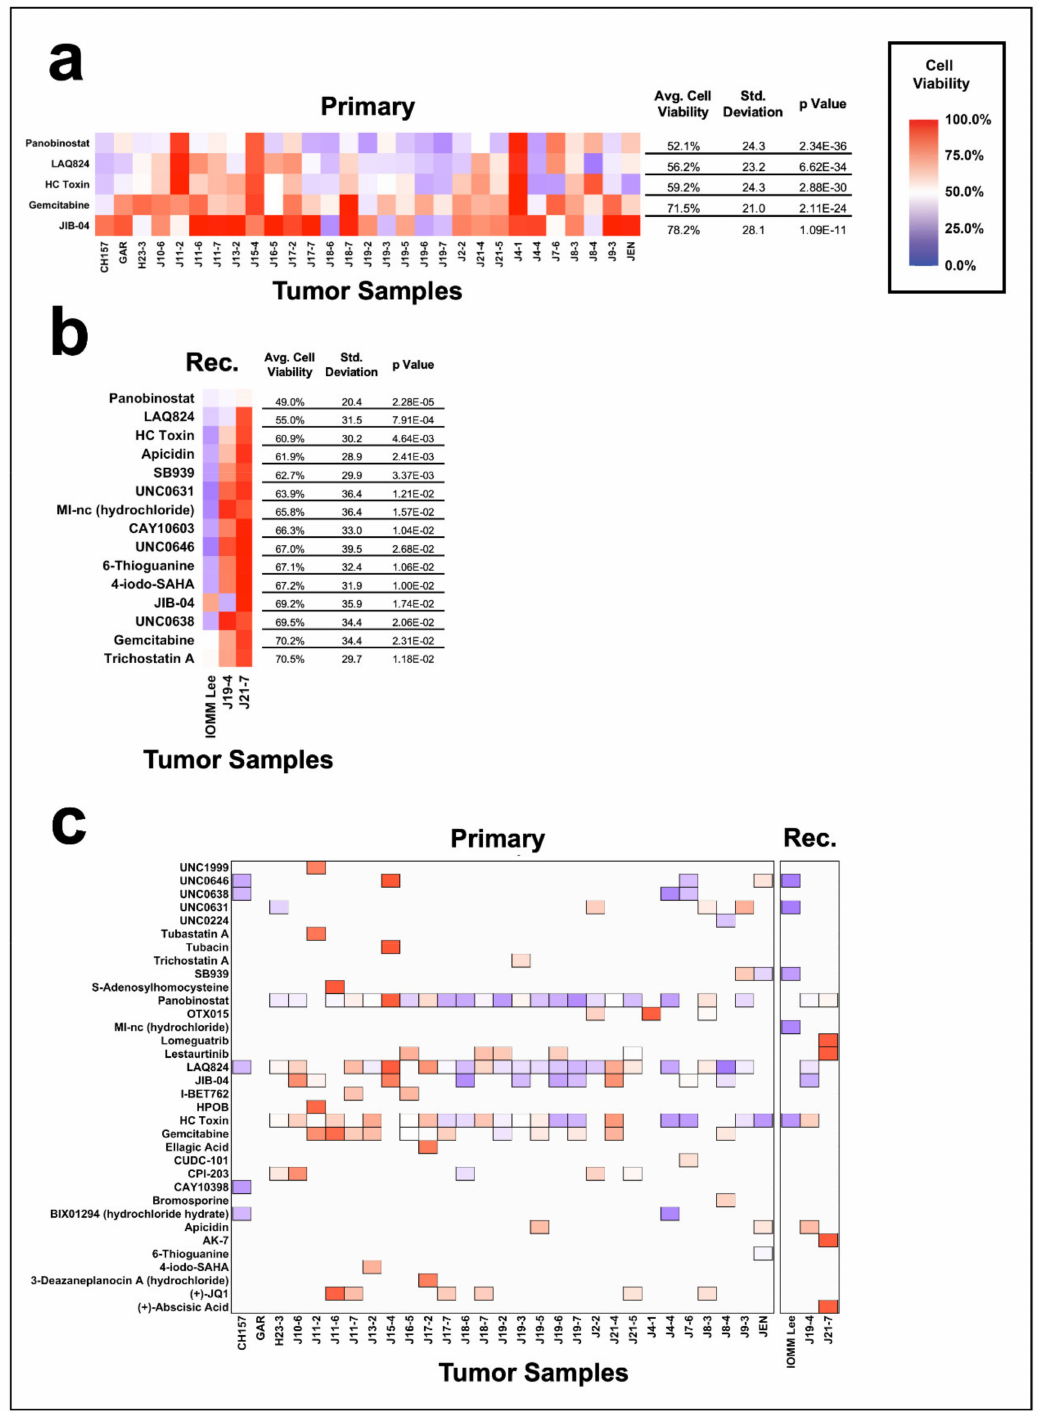
Figure 4. Comparison of the meningioma cohort separated by primary and recurrent tumors. Heat maps displaying the broadly effective compounds for ( a ) primary meningiomas and ( b ) recurrent (denoted as “Rec”) meningiomas. Broadly effective compounds for primary and recurrent meningiomas are identified as compounds that reduce the average cell viability of the group to 80% or less and have a p value of less than 0.05. Heat maps were limited to the top 15 most effective compounds when applicable. ( c ) Heat map of the top five most effective epigenetic compounds, separated by primary and recurrent (denoted as “Rec.”) meningiomas. The top five compounds are displayed as filled tiles in the heat map, while compounds that were not in the top five remain as white